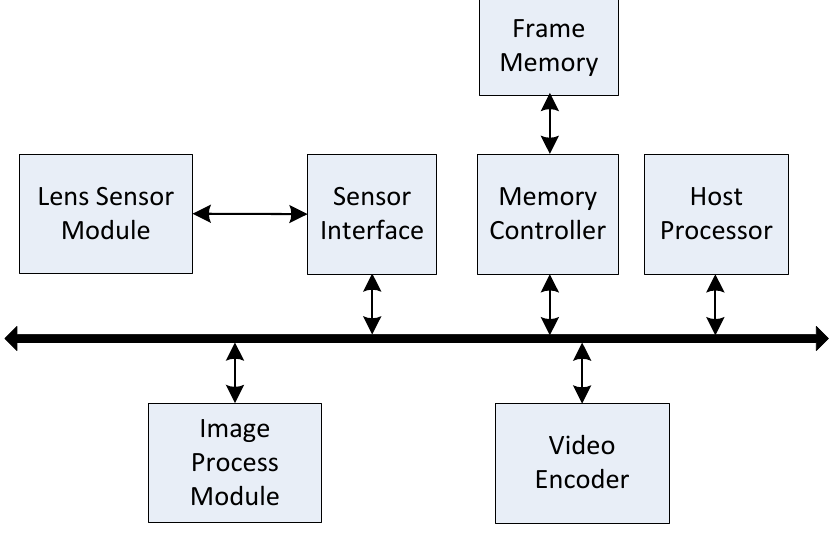
Figure 1. Block diagram of a video-acquisition